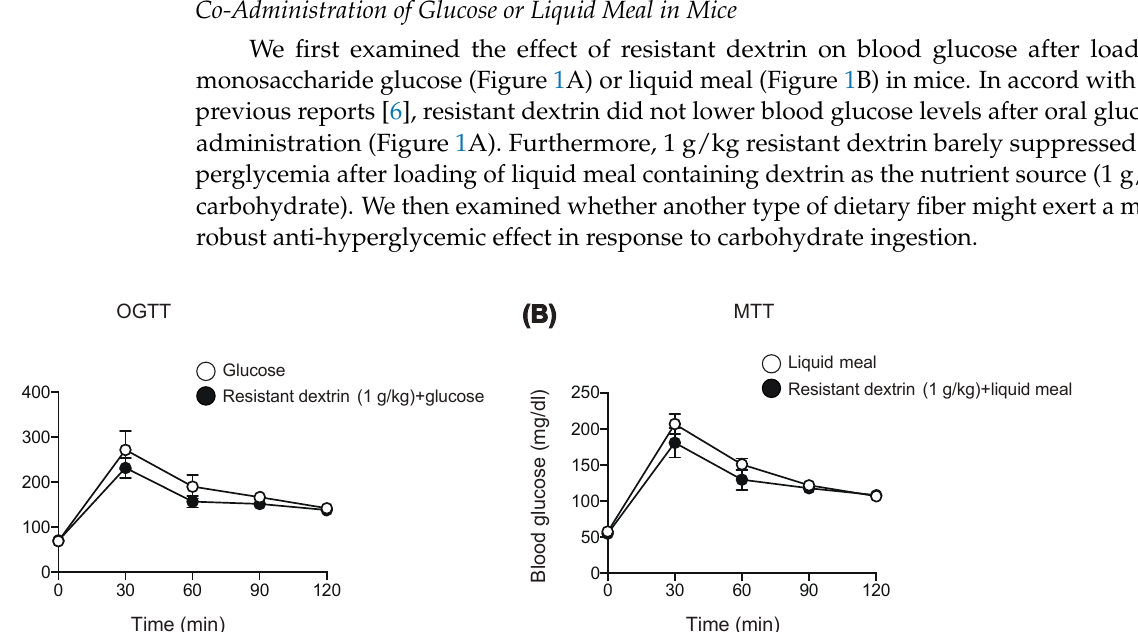
Figure 1. Effect of resistant dextrin on glycemia after glucose or meal loading. Blood glucose levels were measured after glucose (1 g/kg) ( A ) or liquid meal (10 μ L/g BW) ( B ) in WT mice. Bars depict mean ± SEM ( n = 4–5).